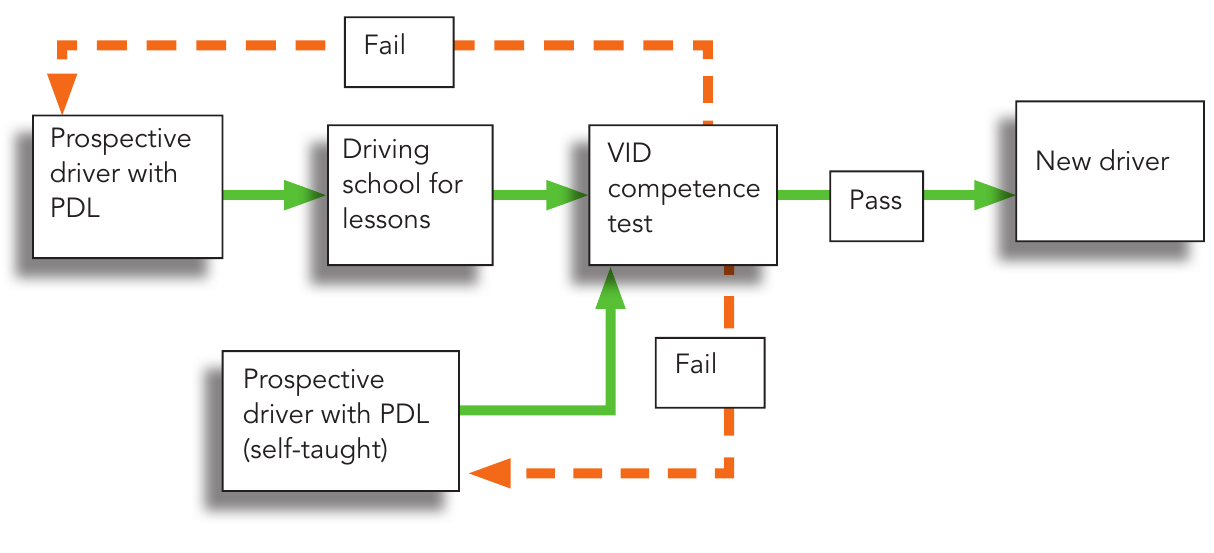
Figure 1: Learner driver testing system prior to